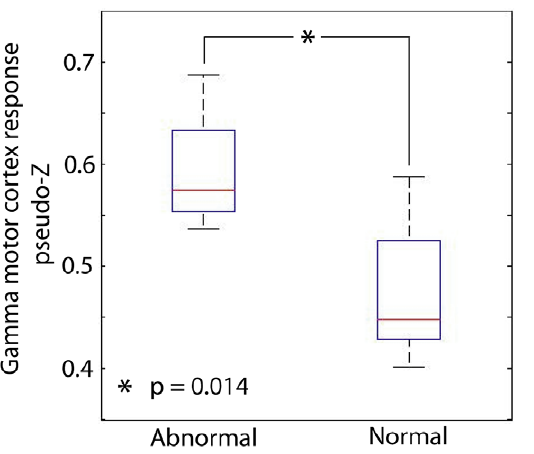
Figure 2. Altered Rolandic MEG response in children with motor impairment. The amplitude of gamma1 (36–44 Hz) response was increased within the epileptogenic hemisphere of children with abnormal motor function.